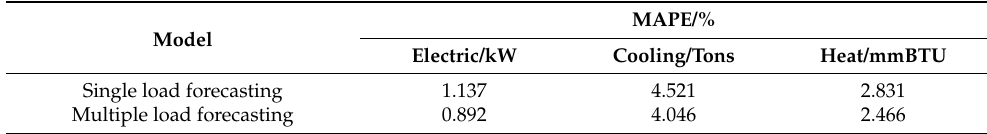
Table 5. Single load forecasting and multivariate load forecasting results.